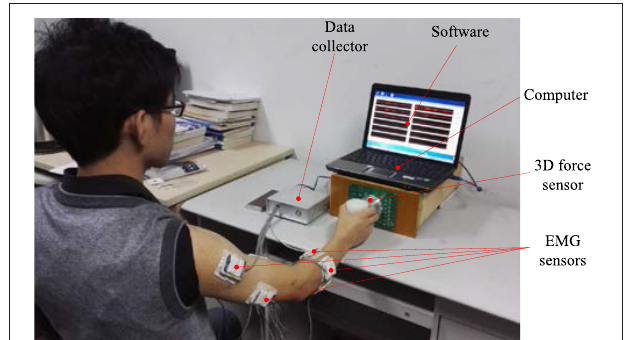
FIGURE 2 | The experimental platform.